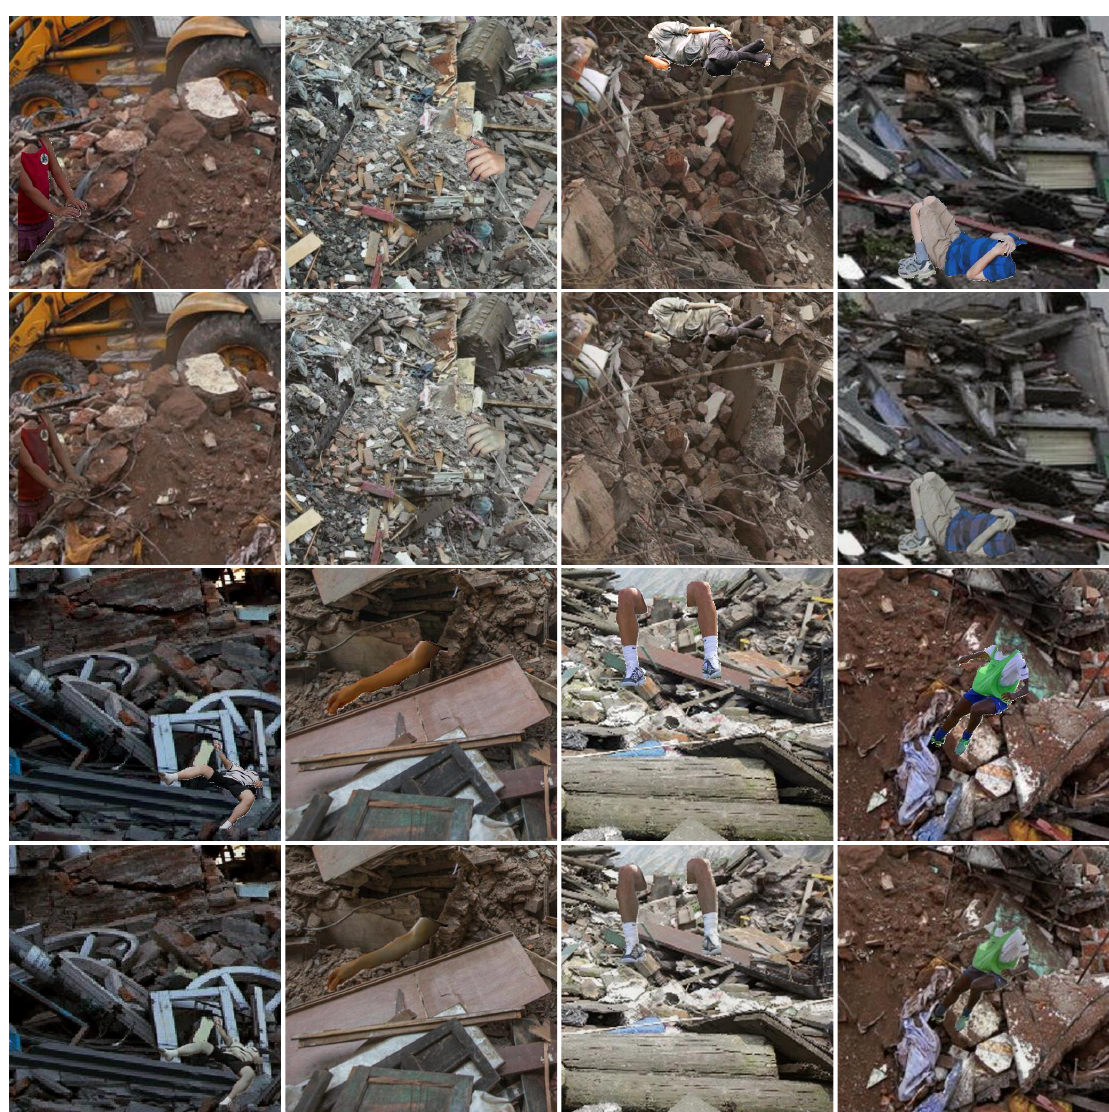
Figure 5. Sample images from our dataset. The images in the first and third rows are composite images obtained using the method illustrated in Section 3.1. The second and fourth rows are the corresponding harmonized images generated by the harmonization network introduced in Section